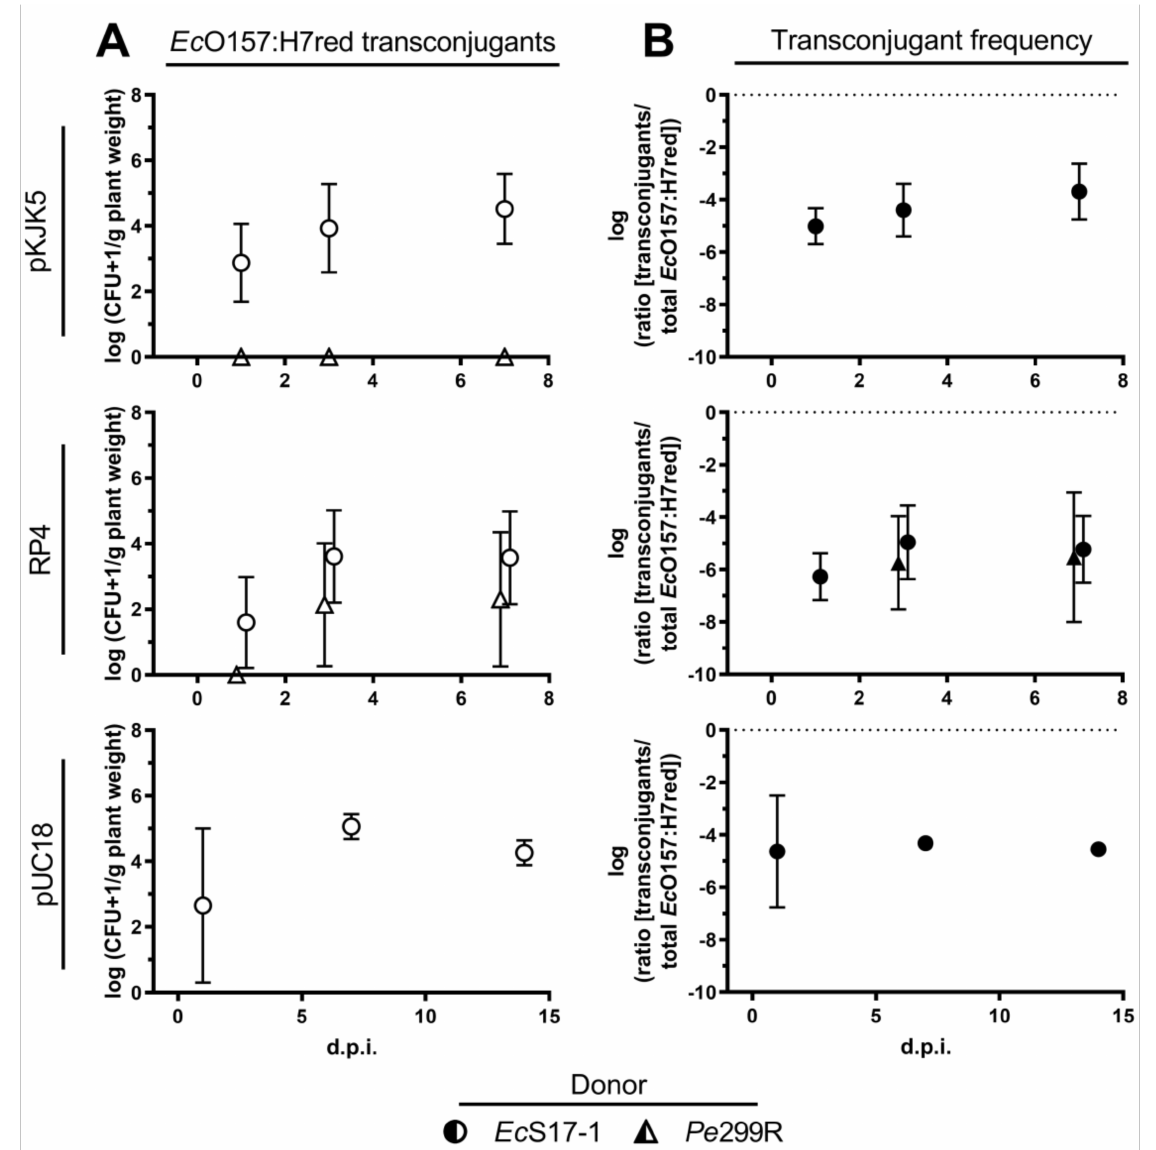
Figure 4. Conjugation dynamics of transconjugant Ec O157:H7red on gnotobiotic A. thaliana . ( A ) Population development of transconjugant Ec O157:H7red after co-inoculation with donors Ec S17-1 (circles) and Pe 299R (triangles) harbouring pKJK5 (top), RP4 (middle), and pUC18 (bottom) onto gnotobiotic A. thaliana after 1, 3, and 7 d.p.i. ( B ) Frequency of Ec O157:H7red transconjugants in the recipient population after co-inoculation with donors Ec S17-1 (circles) and Pe 299R (triangles) harbouring pKJK5 (top), RP4 (middle), and pUC18 (bottom) onto gnotobiotic A. thaliana after 1, 3, and 7 d.p.i. The conjugation with Pe 299R (pKJK5) did not yield transconjugants above the limit of detection. Error bars represent the standard deviation of the